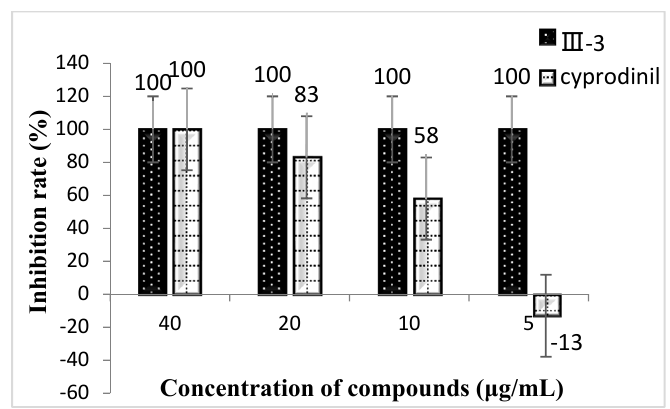
Figure 6. Effect of compound III-3 on the sclerotia production of B cinerea .